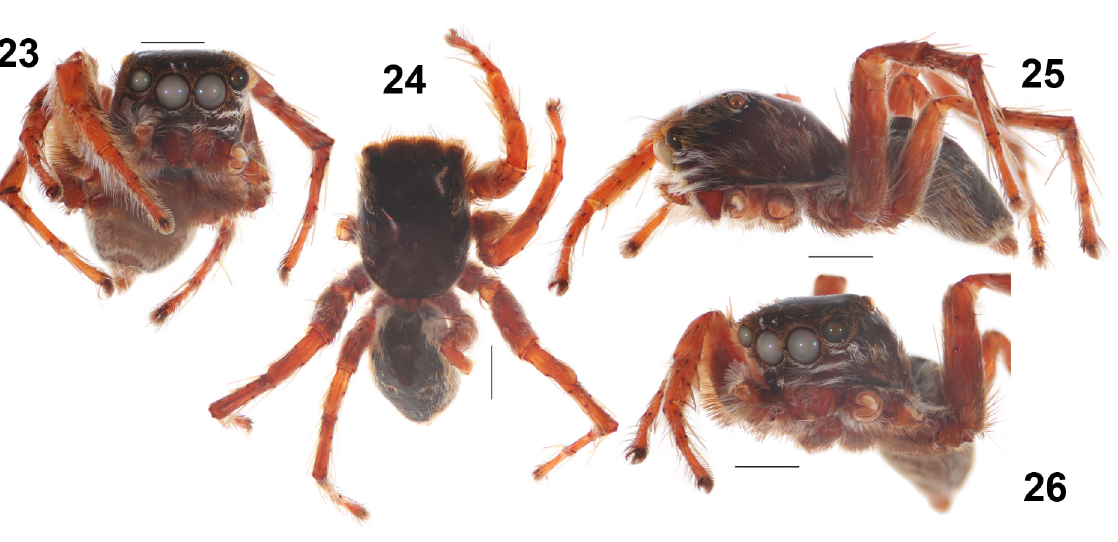
Figs 23–26. Rafalus christophori Prószyński, 1999, holotype, ♂, general appearance. Scale bars: 1